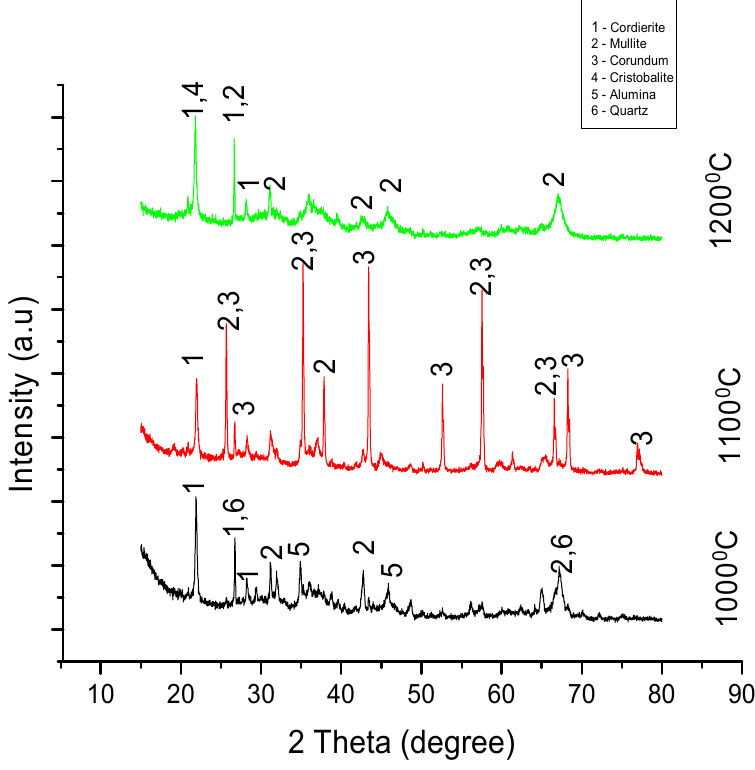
Figure 5. XRD peaks for samples in experiment A sintered at 1000 °C, 1100 °C, and 1200 °C.